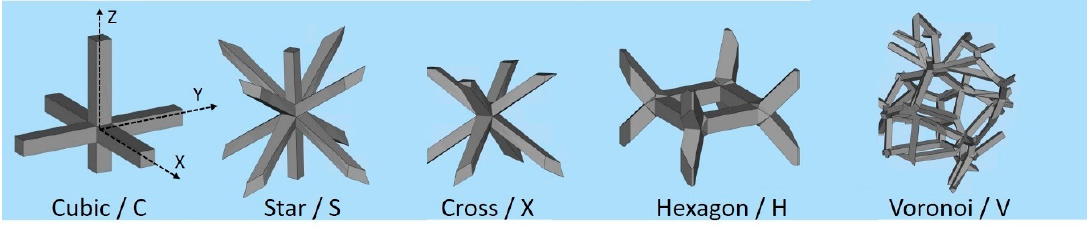
Table 1. Nominal percent porosity (as per Computer-Aided Design—CAD) of the structures investigated.